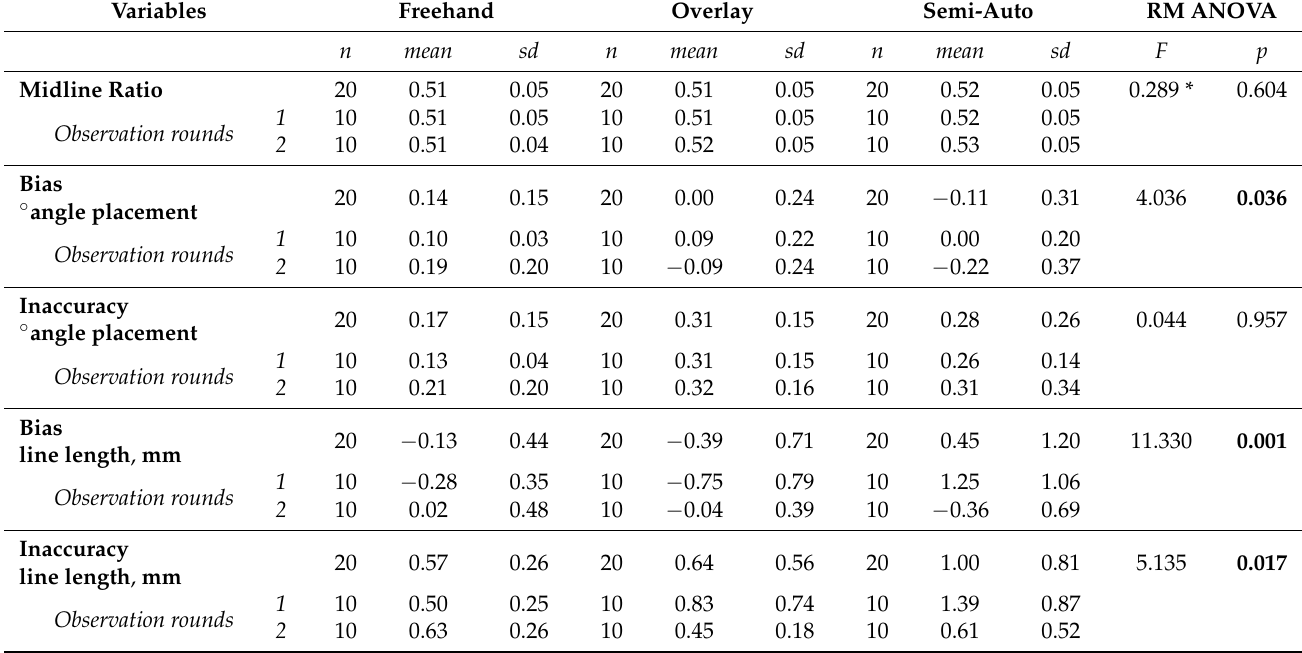
Table 2. Intraobserver error summary statistics and the results of two-way (round*mode) repeated measures analysis of variance (RM ANOVA) across the three modes using transformed